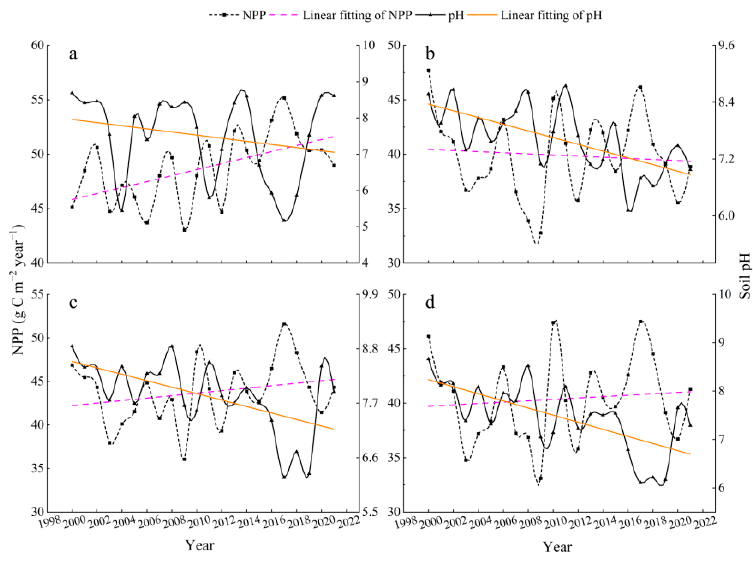
Figure 7. Interannual variations of pH and NPP in grassland ecosystems during 2000–2021: ( a ) pH and NPP of temperate steppes, ( b ) pH and NPP of swamps, ( c ) pH and NPP of montane meadows, and ( d ) pH and NPP of alpine meadows.